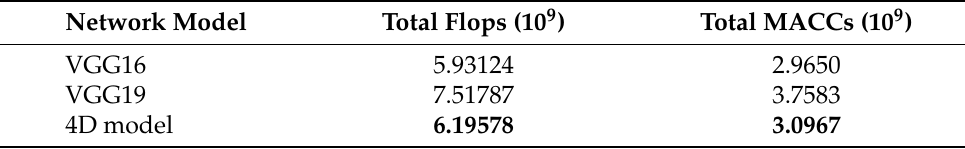
Table 3. Flops and